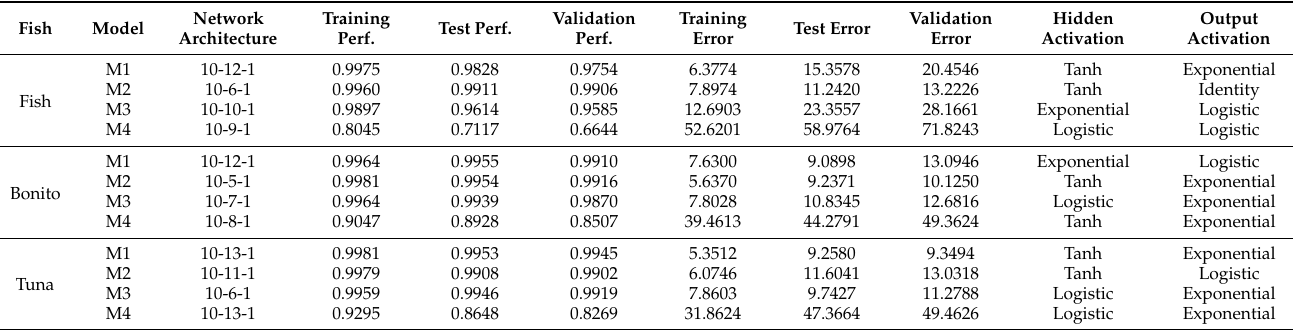
Table 4. Artificial neural network models for histamine prediction of calibration sample sets for combined fish samples (Fish) and individual fish species (Tuna, Bonito). Fish